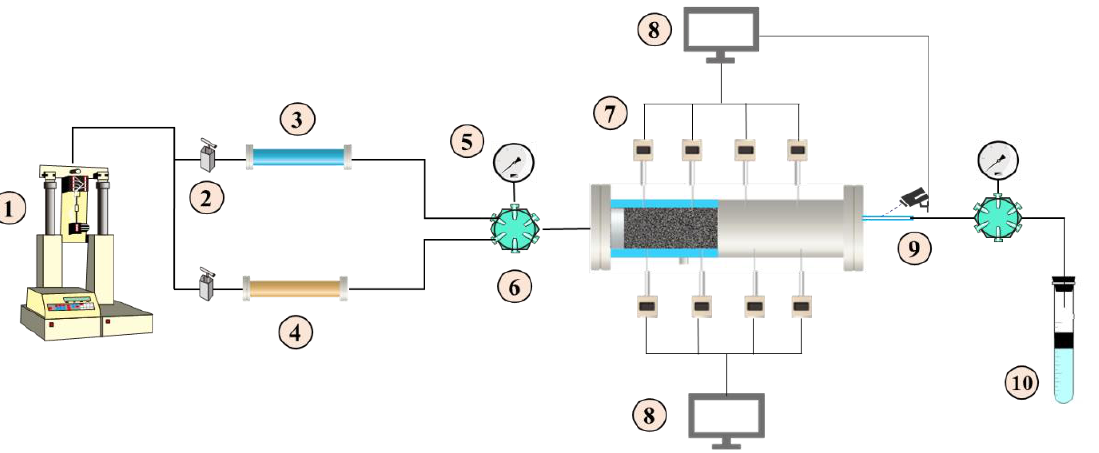
Figure 2. Dynamic capillary-force monitoring experimental equipment. ○ 1 . Pump; ○ 2 . valves; ○ 3 . intermediate container (water); ○ 4 . intermediate container (oil); ○ 5 . pressure gauge; ○ 6 . six-way valve; ○ 7 . multifunction sensor; ○ 8 . monitoring system; ○ 9 . real-time metering device; ○ 10 . me- tering device.